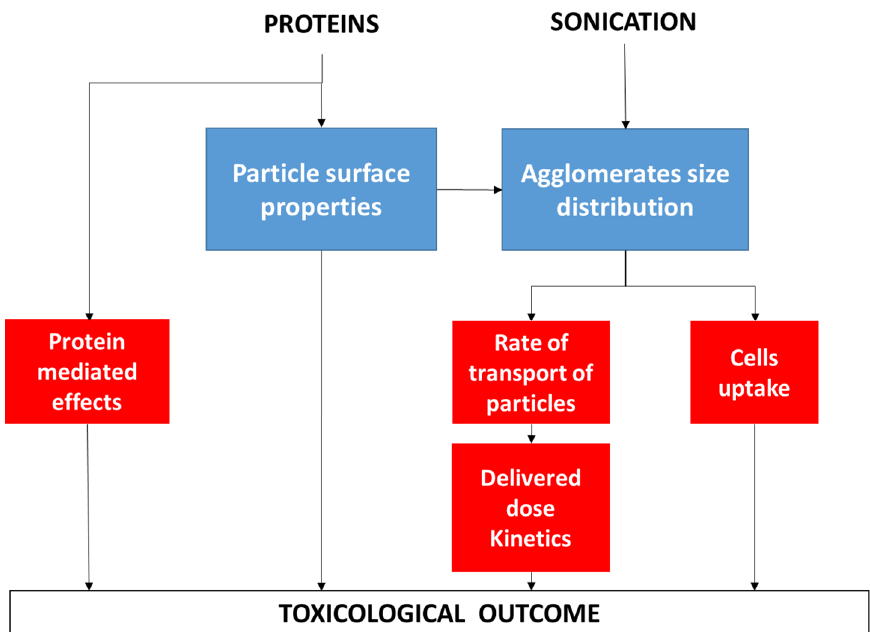
Figure 11. Summary of the possible e ff ects of proteins and sonication on the nanomaterials toxicity. The formation of a protein corona a ff ects the surface properties of the particles (charge, reactivity, topography) that in turn may a ff ects both agglomerates size distribution and cell response. Protein mediated e ff ects may occur depending upon the protein corona composition and the arrangement of the proteins at the surface. Sonication a ff ects the agglomeration size distribution that in turn modulate the rate of transport and the cell uptake.